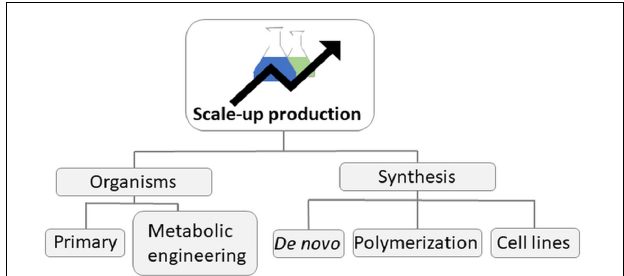
FIGURE 3 | Production scale-up possibilities.